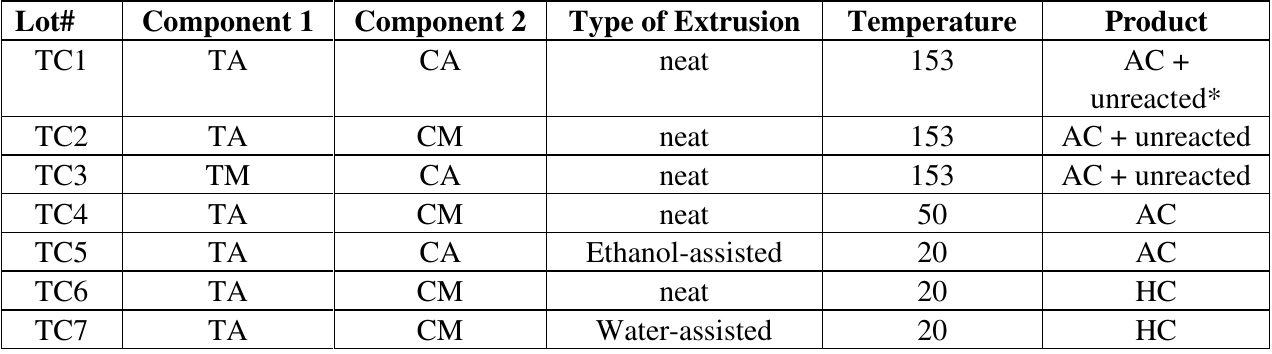
Table 2. Outcome of TSE experiments performed with Theophylline-Citric acid system.